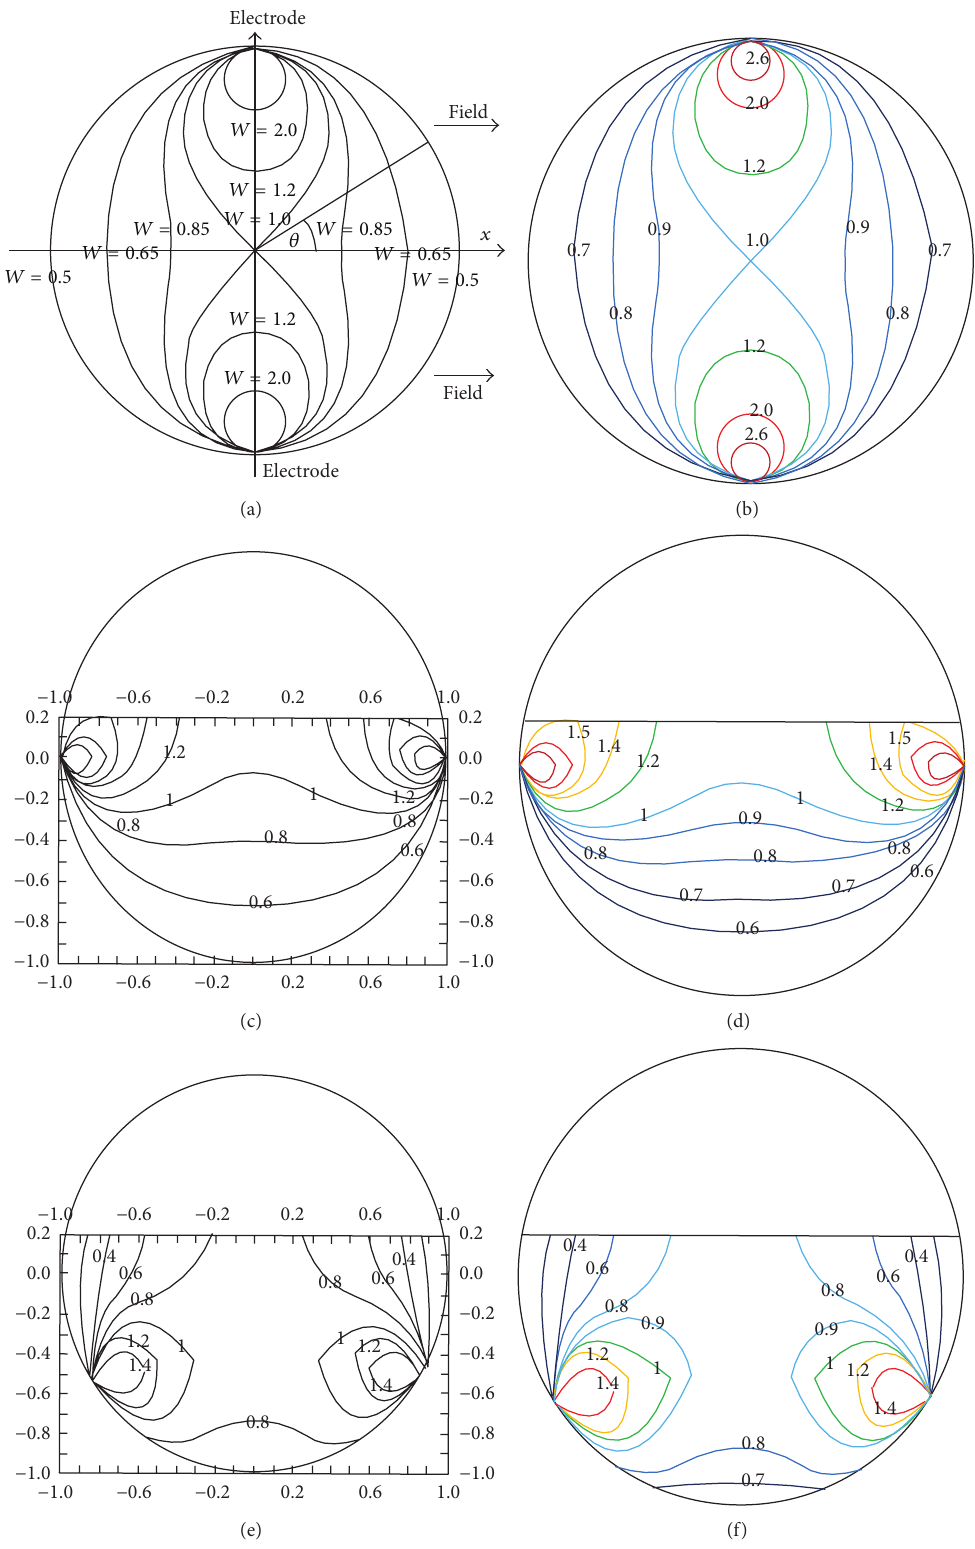
Figure 3: (a)–(f) The distributions of the weight function [8, 9] and the current simulated using the proposed